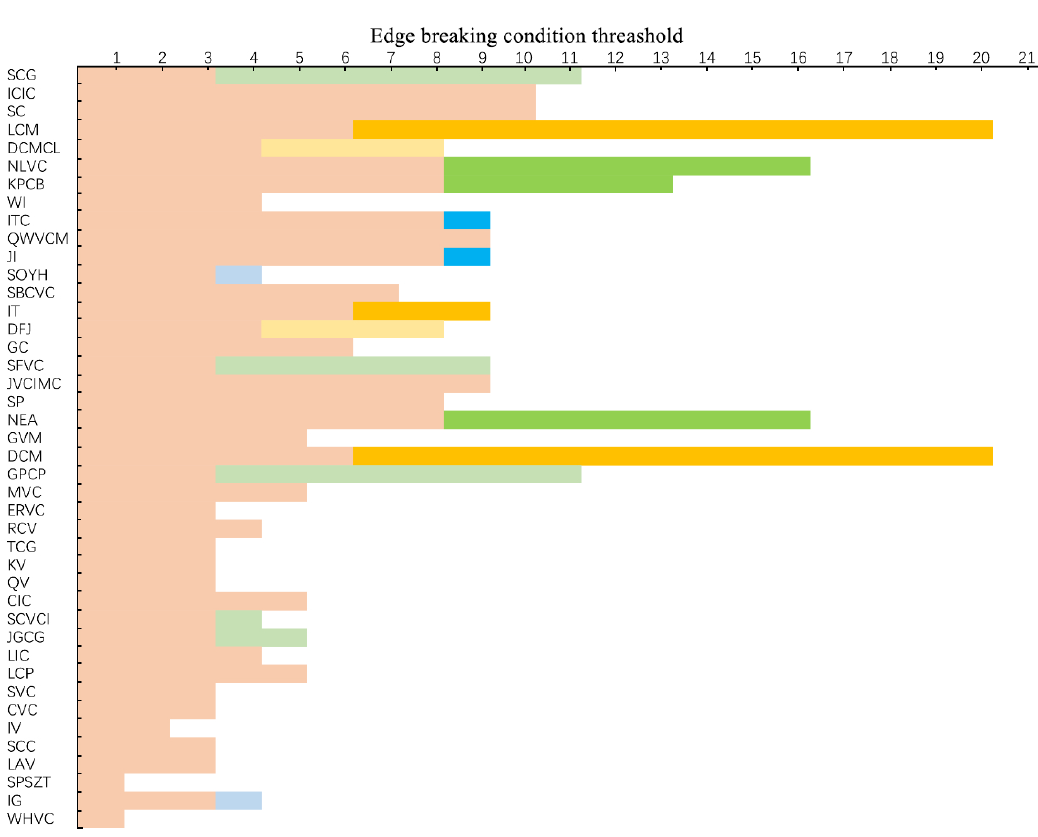
Fig. 2 Evolution of components of 42 VC industry